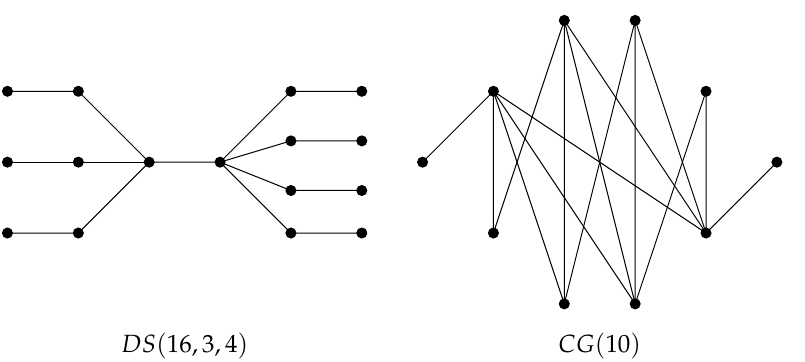
Figure 1. Double star-type graph DS ( 16,3,4 ) on 16 vertices and the chain graph CG ( 10 ) on 10